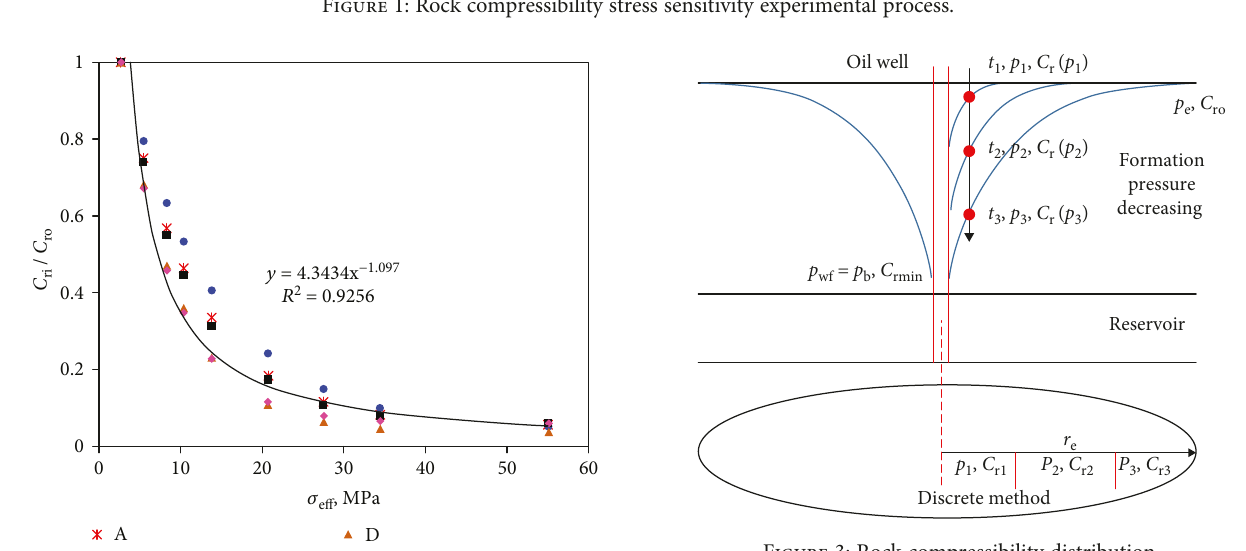
Figure 3: Rock compressibility